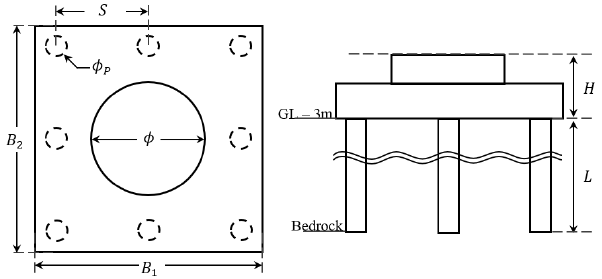
Figure 2. The shape of the piled